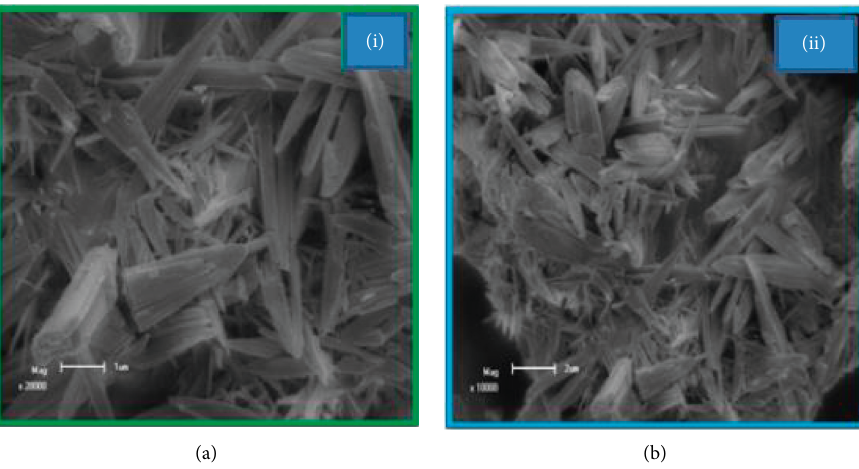
Figure 3: Scanning electron microscopy of (a) biosynthesized magnesium oxide (MgO) from Datura stramonium leaves extract at 20000 magnification and (b) chemosynthesized nanoparticles at 10000 magnification. 0.00.20.40.60.81.0